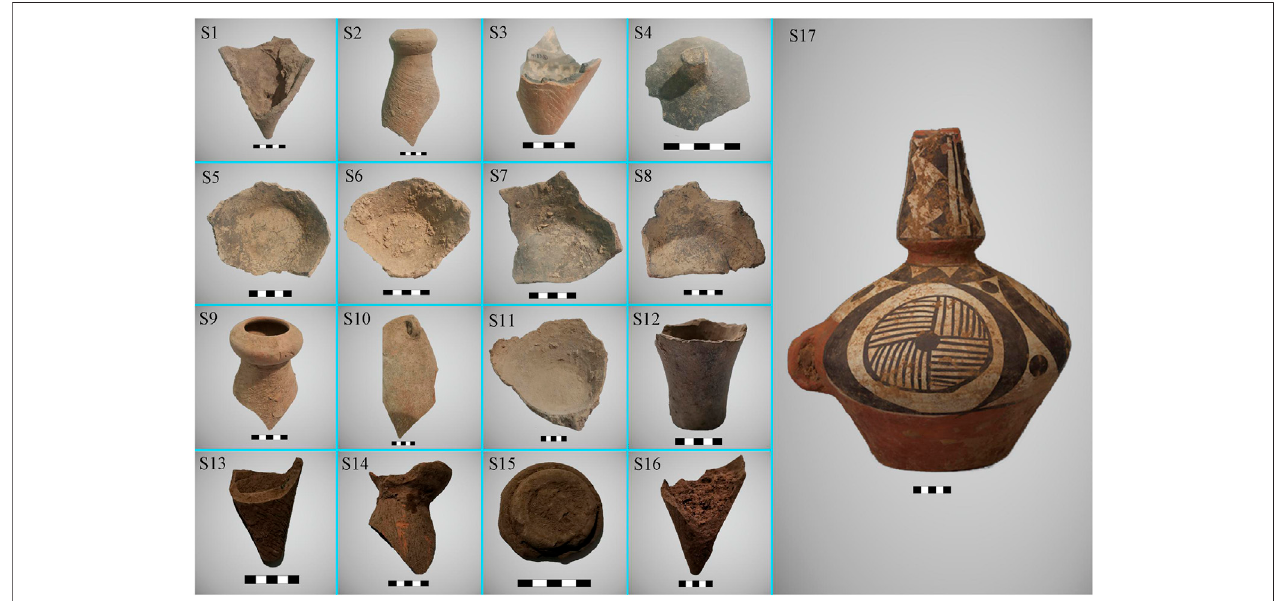
FIGURE2| PotterysamplesfromtheQingtaisite(scalebar:5 cm).S1, Jiandipng ;S2, jiandipng ;S3,funnel(aholeinthebottom);S4,lip;S5,jar;S6,jar;S7,jar;S8, jar; S9, jiandipng ; S10, jiandiping ; S11, jar; S12, cup; S13, jiandipng ; S14, jiandipng ; S15, lip; S16, jiandipng ; S17, painted bottle.